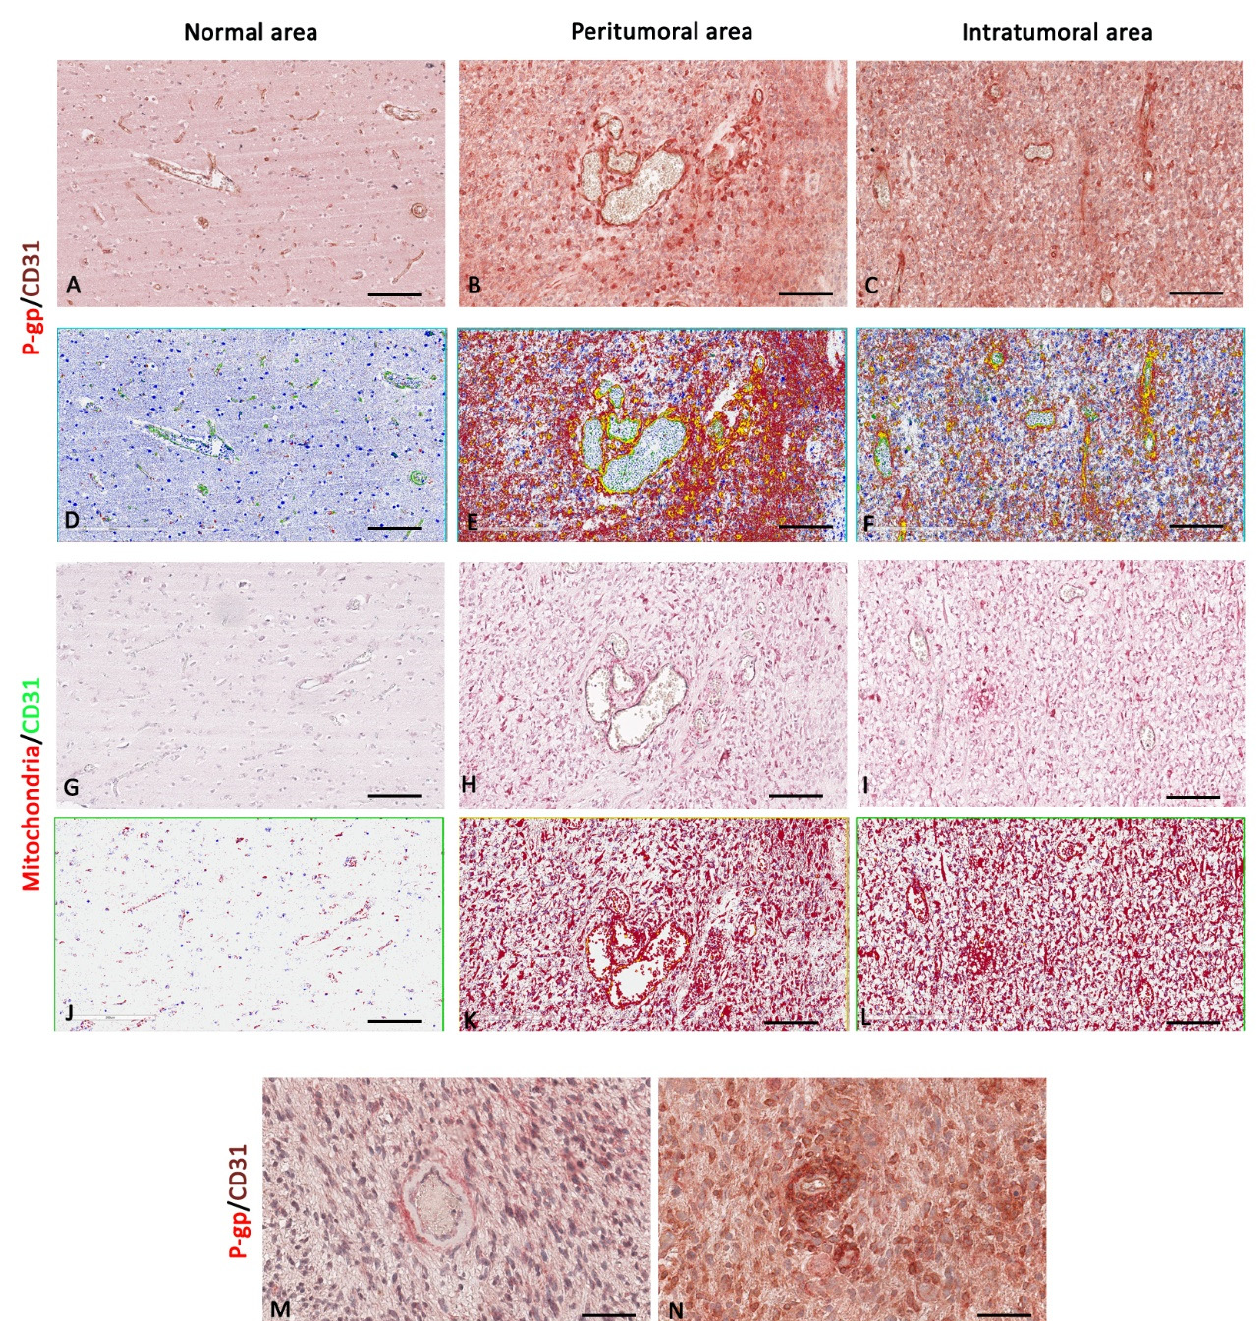
Figure 8. P-gp/CD31 and mitochondria/CD31 expression and colocalization in IDH-WT glioblas- toma. P-gp, mitochondria, and CD31 were evaluated by immunohistochemistry within the same spatial ROIs on IDH-WT glioblastoma serial sections. P-gp ( A – F ), mitochondria ( G – L ), and CD31